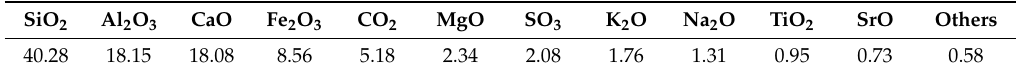
Table 3. Chemical composition of class I fly ash (%).